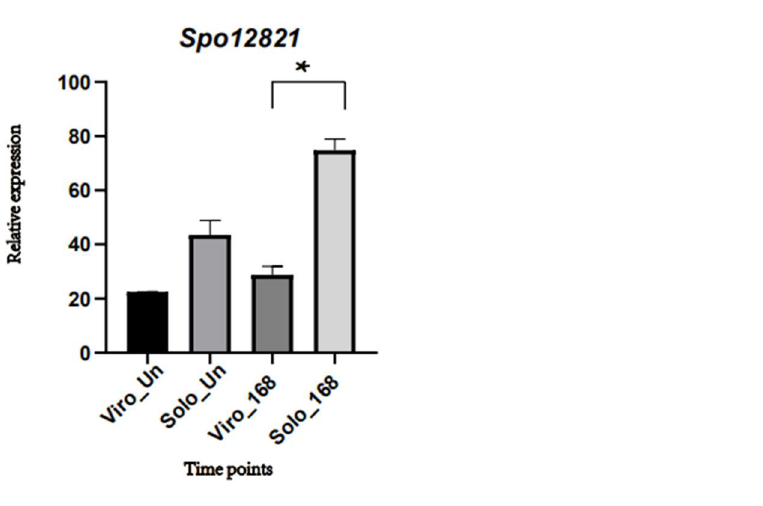
Figure 5. Relative expression of the gene Spo12821 in resistant cultivar Solomon and susceptible cultivar Viroflay inoculated with Peronospora effuse at 168 h post-inoculation period (hpi) and un-inoculated control. * Represented significant difference ( p < 0.05).